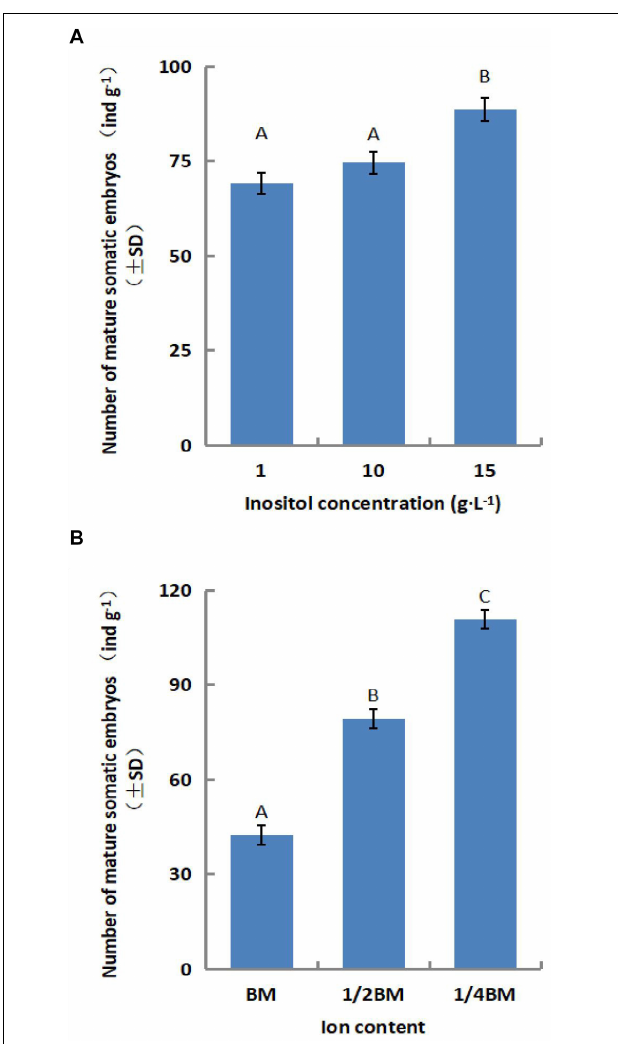
FIGURE 3 | Effect of the SM composition on somatic embryo maturation of L. olgensis. The effects of (A) inositol concentration and (B) ion content on the number of somatic embryos. SM contained 1/4 BM salts, 10 g · L − 1 inositol, 1 g · L − 1 glutamine, 0.5 g · L − 1 hydrolyzed casein, and 60 g · L − 1 sucrose. Each value represents the mean of three independent experiments with standard deviation (SD). Different letters indicate p < 0.05 (Duncan’s multiple range test).